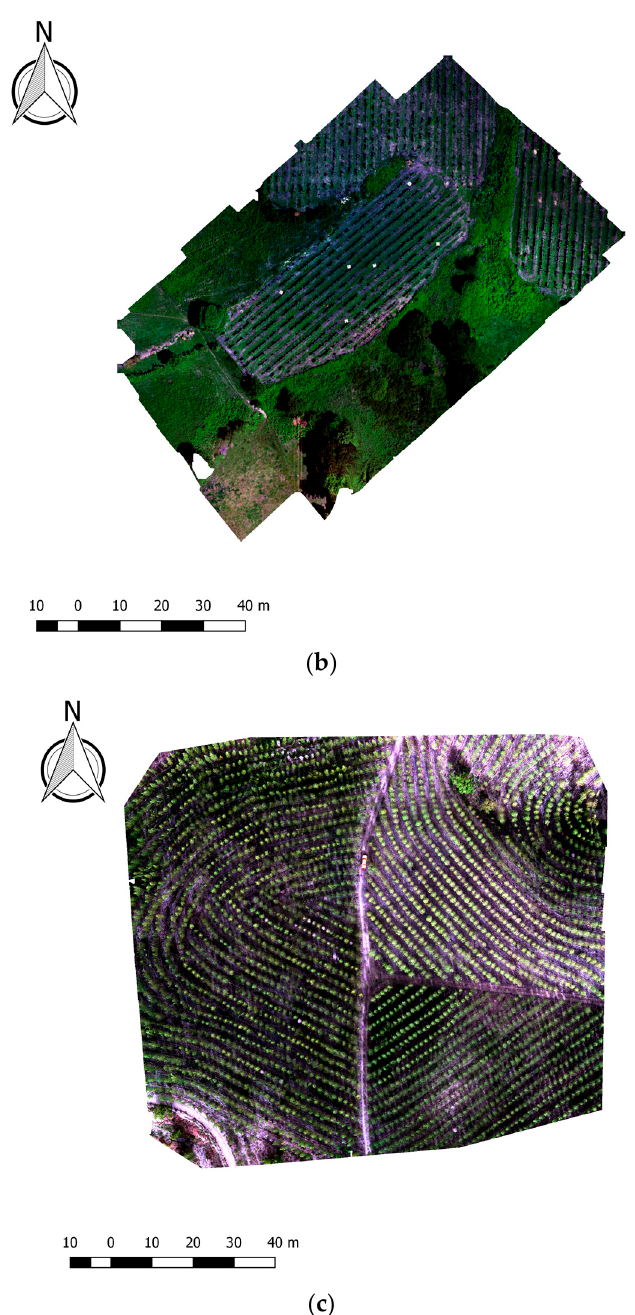
Figure 1. Study cases: ( a ) olive crop; ( b ) eucalyptus crop; and, ( c ) vineyard crop.